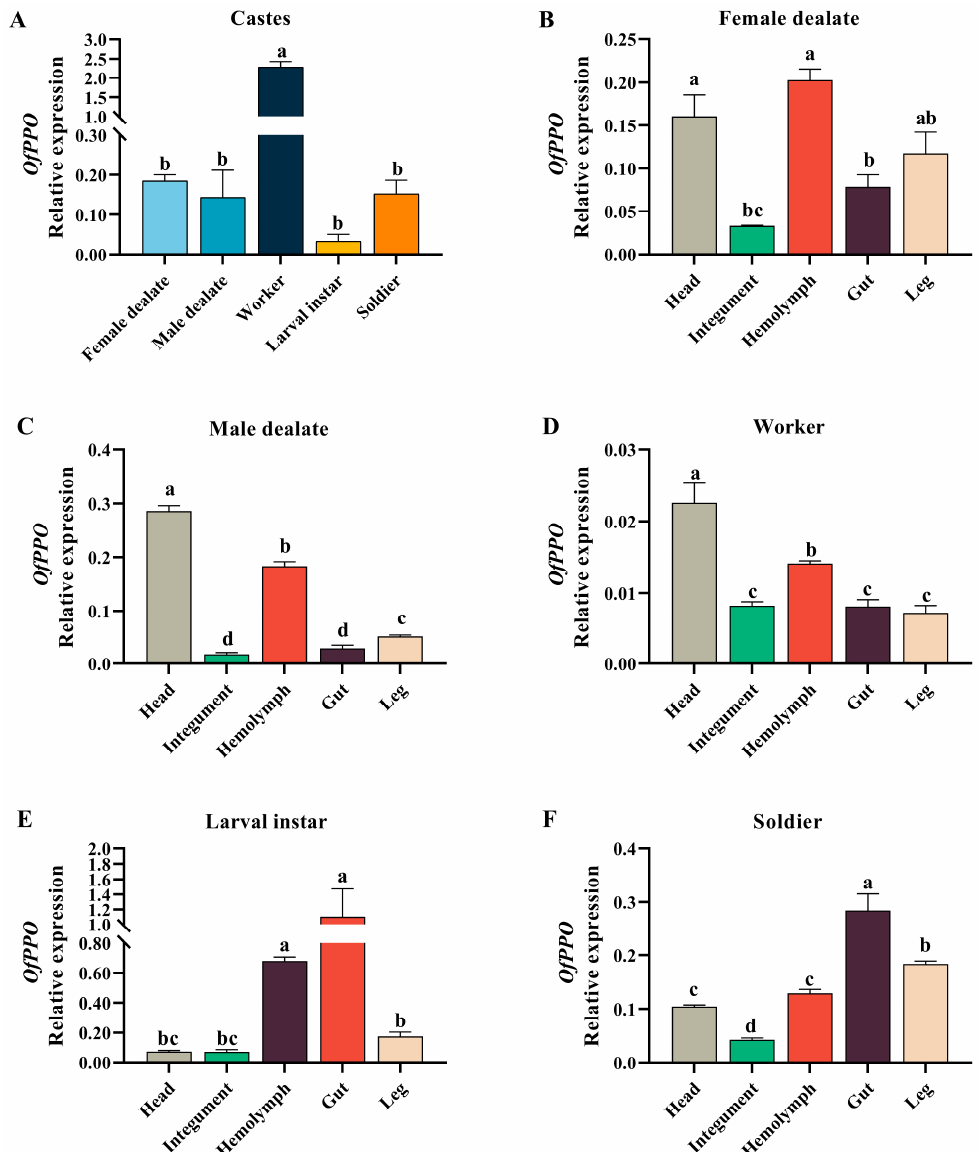
Figure 4. Expression profiles of OfPPO in different castes and tissues of O. formosanus . ( A ) OfPPO mRNA expression levels in five castes. ( B ) OfPPO mRNA expression levels in five tissues of female dealates. ( C ) OfPPO mRNA expression levels in five tissues of male dealates. ( D ) OfPPO mRNA expression levels in five tissues of worker. ( E ) OfPPO mRNA expression levels in five tissues of larval instars. ( F ) OfPPO mRNA expression levels in five tissues of soldiers. The data are presented as the mean ± SD of three replicate samples. The same letters on the error bars indicate no significant difference in OfPPO expression ( p > 0.05) .